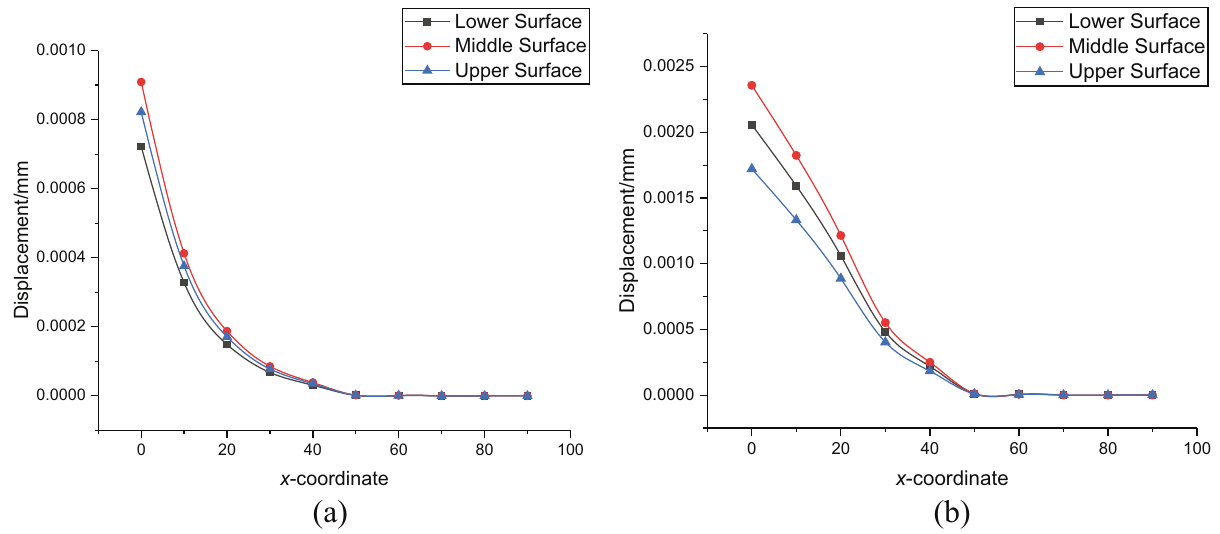
Figure 10: The upper, middle, and lower surface displacement changes along the x - direction with di ff erent parameters. ( a ) p = 0.5 and ( b ) p =